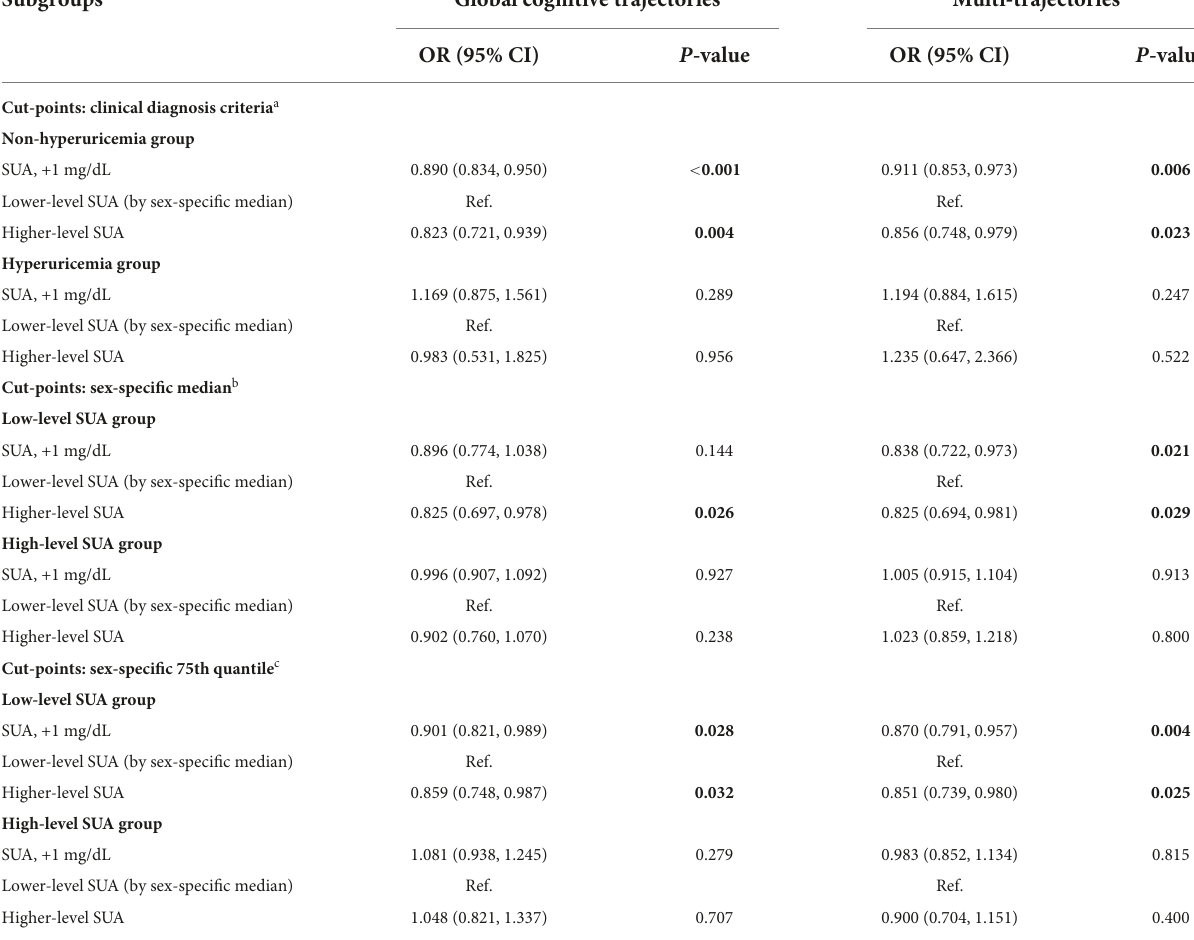
TABLE 3 Associations between baseline SUA and cognitive trajectories in subgroups by SUA